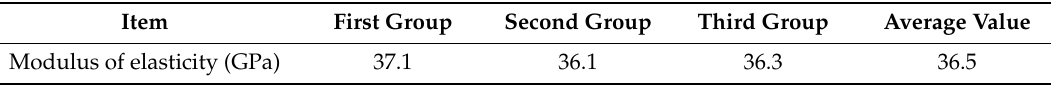
Table A9. Elastic modulus obtained from the experimental test on C80